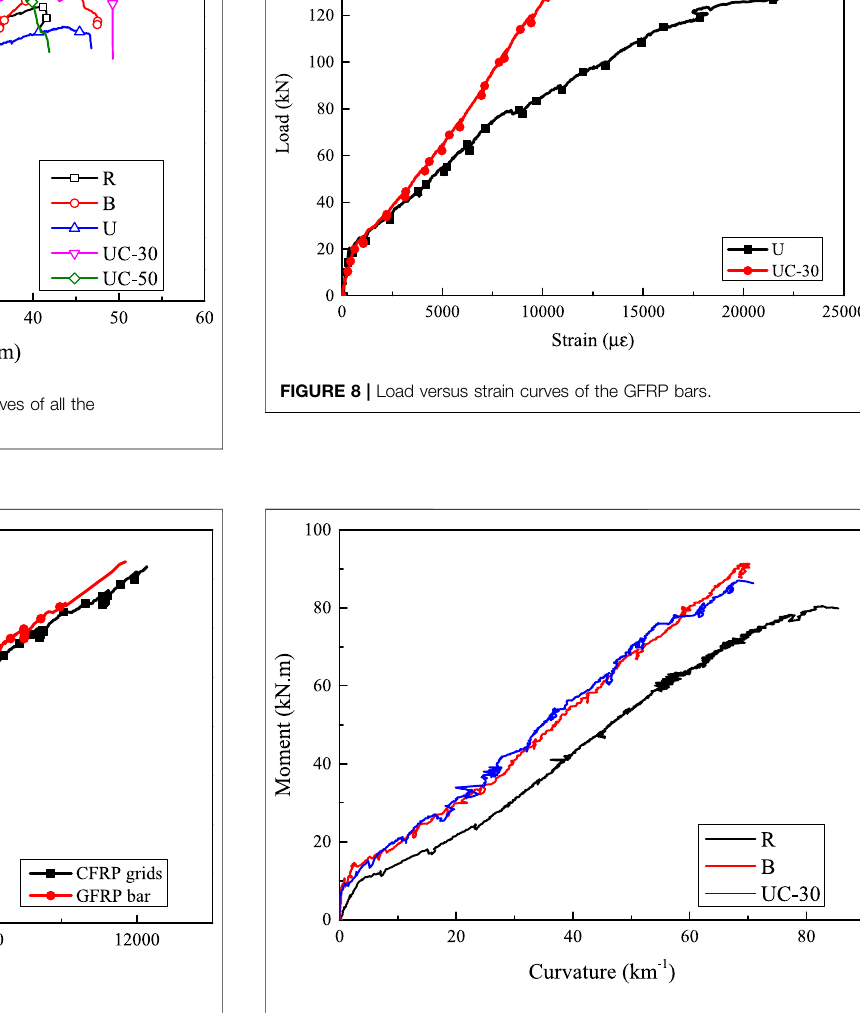
FIGURE 9 | Moment-curvature responses of composite